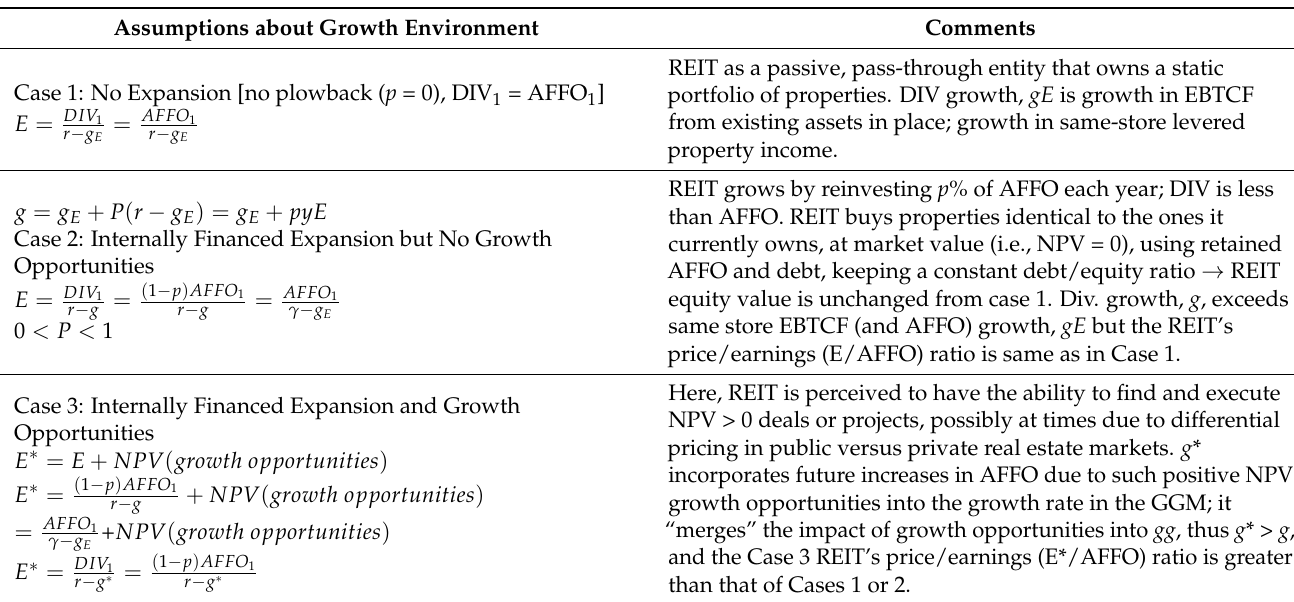
Table 2. Three cases of GGM of REIT Share